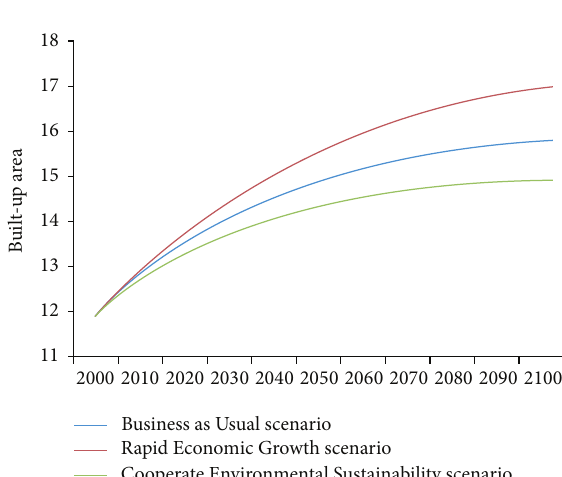
Figure 2: Simulated changes of LUCC area (measured in million ha) in China, 2010–2100.